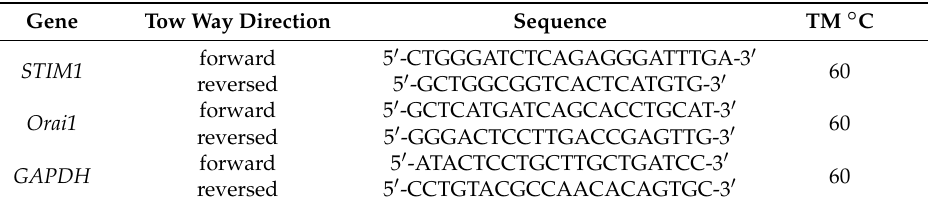
Table 1. Primer sequences used QPCR analysis with gene